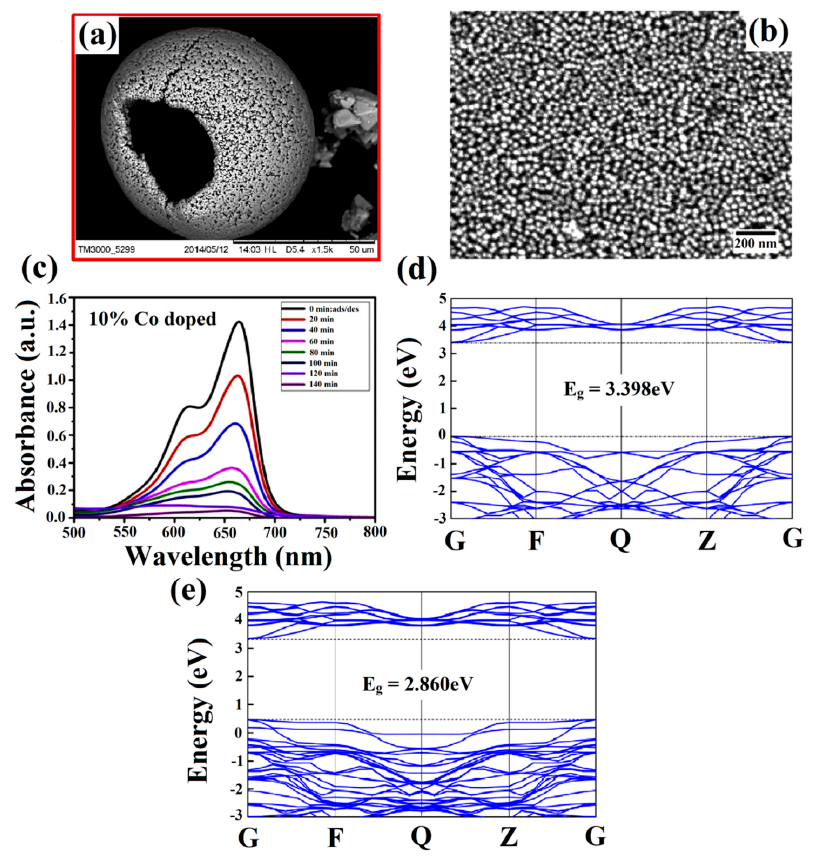
Figure 3. SEM images of ( a ) ZrO 2 : Mg 2+ 2 mol%, reprinted with permission from Elsevier (License NO. 5332611047818) [45], ( b ) Co-doped ZrO 2 , ( c ) photodegradation of MB of 10% by Co doped ZrO 2 in visible light exposure, reprinted with permission from Elsevier (License NO. 5332971176132) [25], ( d ) band structure of pure ZrO 2 , and ( e ) ZrO 2-x N x [46].